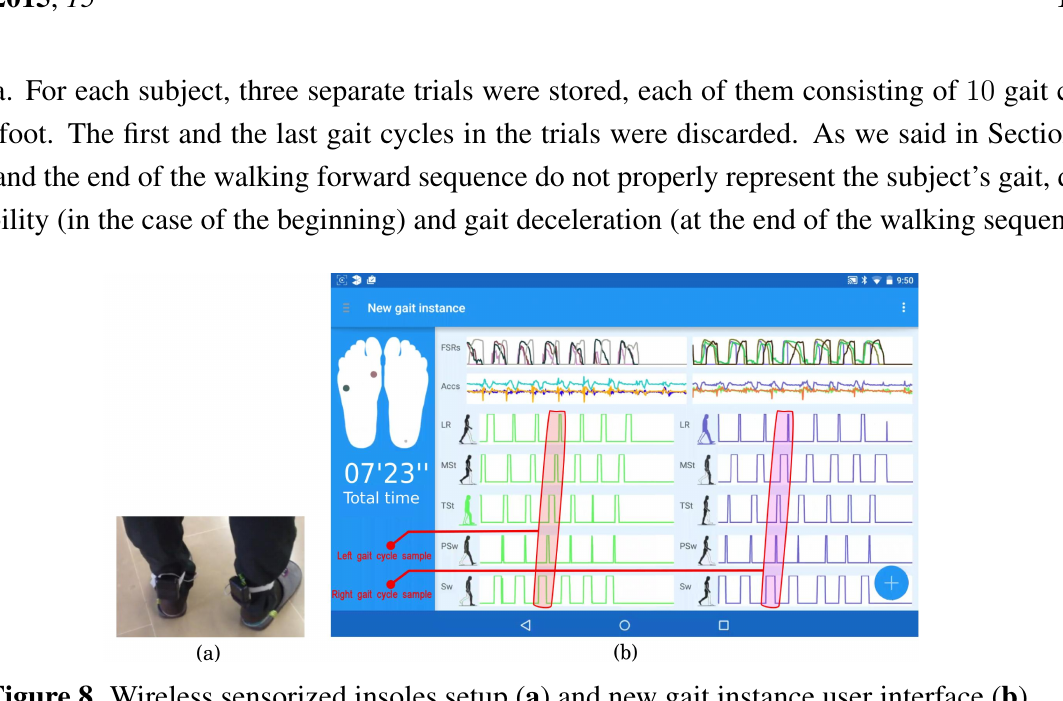
Figure 8. Wireless sensorized insoles setup ( a ) and new gait instance user interface ( b ). For each valid cycle in each trial, the five gait phases of normal gait (LR, MSt, TSt, PSw, Sw)